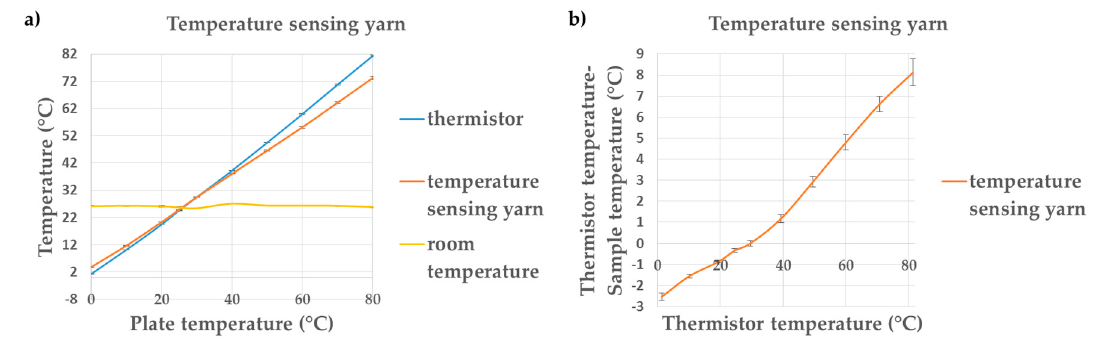
Figure 5. Temperature sensing yarns over a temperature range of 0 °C to 80 °C ( a ) The effects of increasing the plate temperature on the temperature recorded by the thermistor and the temperature sensing yarns; ( b ) The difference between the temperature recorded by the samples compared to the thermistor